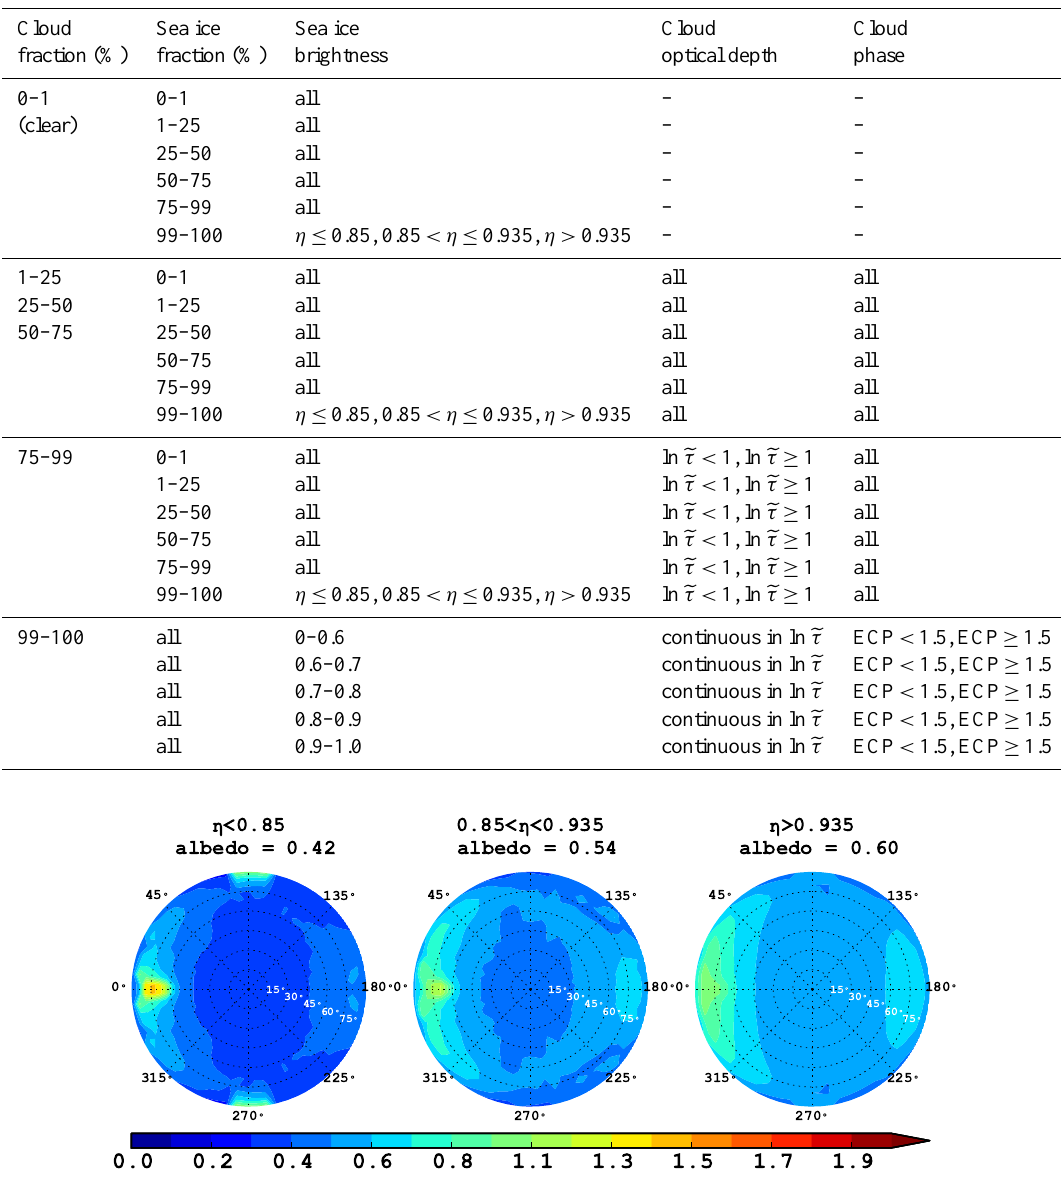
Table 2. Sea ice SW ADM scene type definitions by cloud fraction (%), sea ice fraction (%), sea ice brightness index ( η ), cloud optical depth ( e τ ), and effective cloud phase (ECP).